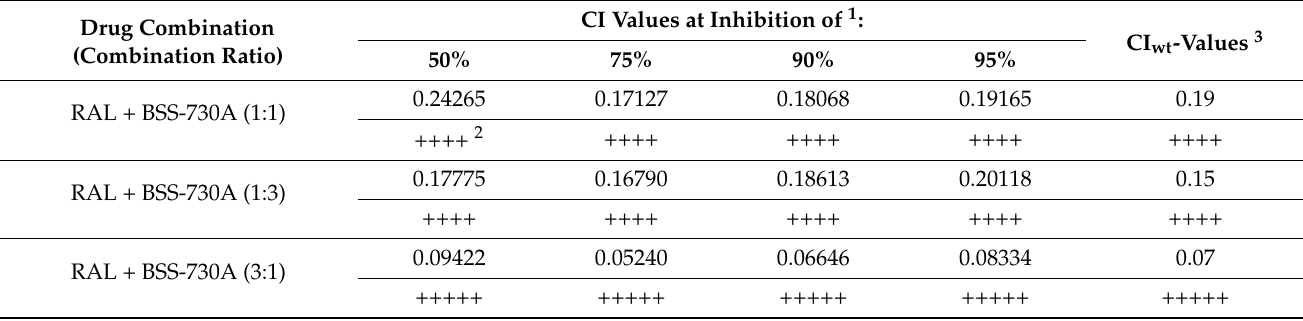
Table 2. Combination indices (CI) of different RAL: BSS-730A combinations against HIV-2. Drug